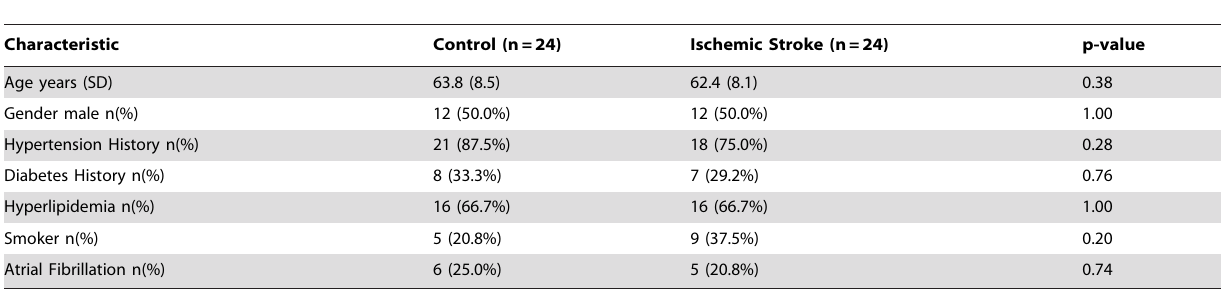
Table 1. Characteristics of ischemic stroke and vascular risk factor control study subjects.